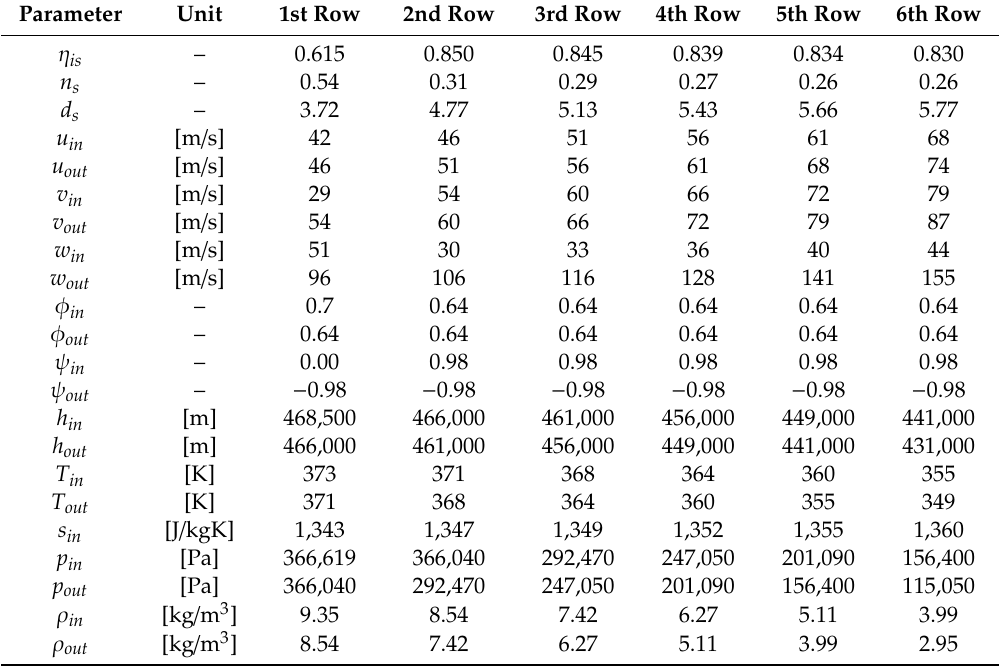
Table 10. Output parameters for the selected